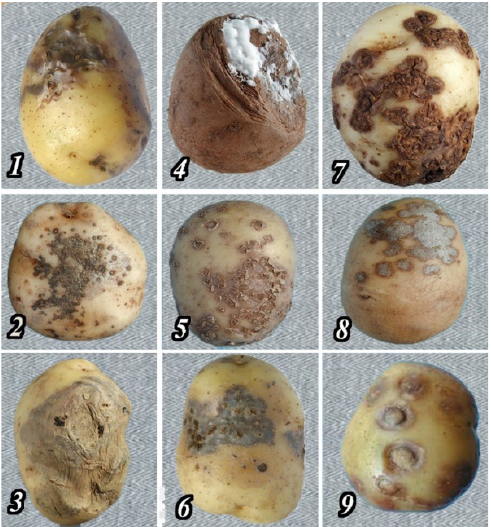
Figure 1. Potato Disease Identification ( 1 . Late blight, 2 . Skin spot, 3 . Gangrene, 4 . Dry rot, 5 . Powdery scab, 6 . Tobacco Necrosis Virus, 7 . Common scab, 8 . Silver scurf, 9 . Potato Virus Y). Late blight rot often turns into dry Fusarium rot (Figure 1(4)) by the middle or end of storage.